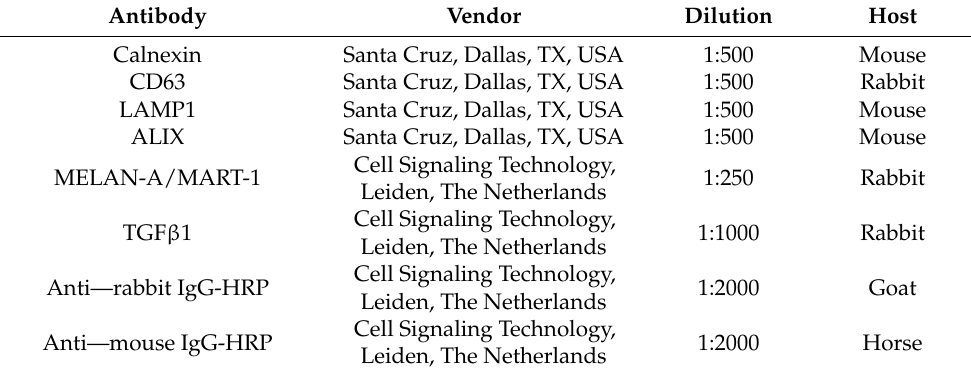
Table 1. Antibodies and dilutions used in Western